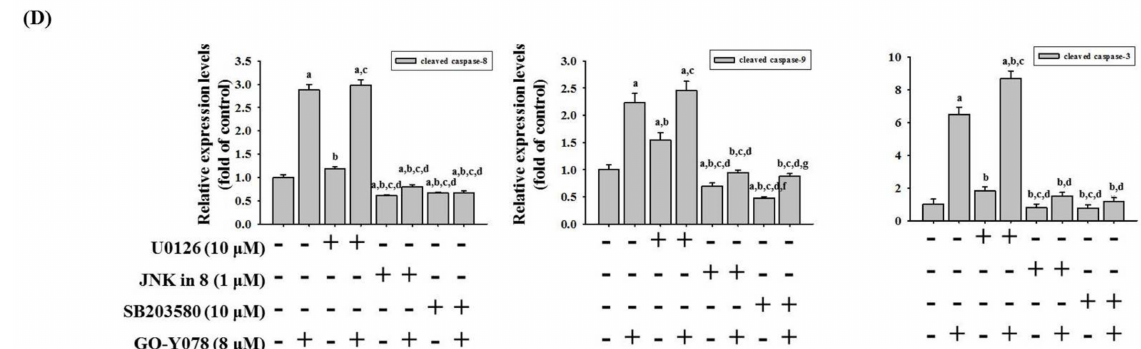
Figure 7. Effects of GO-Y078 and inhibitors of ERK1/2 (U0126), JNK1/2 (JNK-in-8), and p38 (SB203580) on cleaved caspases 8, 9, and 3 expressions of U2OS and 143B cells. Expressions of cleaved caspases 8, 9, and 3 after pretreatment with or without 10 µ M of U0126, 1 µ M of JNK-in-8, and 10 µ M of SB203580 for 1 h followed by 8 µ M or no GO-Y078 treatment for an additional 24 h in ( A ) U2OS and ( B ) 143B cells were measured through Western blot analysis. Next, they were subjected to quantitative analysis. Results are shown as mean ± S.D.; n = 3. − : without treatment; +: with treatment. ANOVA analysis with Tukey’s posteriori comparison was used. ( C ) U2OS: cleaved caspase 8: F = 2913.043, p < 0.001; cleaved caspase 9: F = 348.891, p < 0.001; cleaved caspase 3: F = 2804.587, p < 0.001. ( D ) 143B: cleaved caspase 8: F = 634.867, p < 0.001; cleaved caspase 9: F = 135.304, p < 0.001; cleaved caspase 3: F = 282.973, p < 0.001. a Significantly different, p < 0.05, when compared to control. b Significantly different, p < 0.05, when compared to 8 µ M GO-Y078. c Significantly different, p < 0.05, when compared to U0126. d Significantly different, p < 0.05, when compared to JNK-in-8. e Significantly different, p < 0.05, when compared to